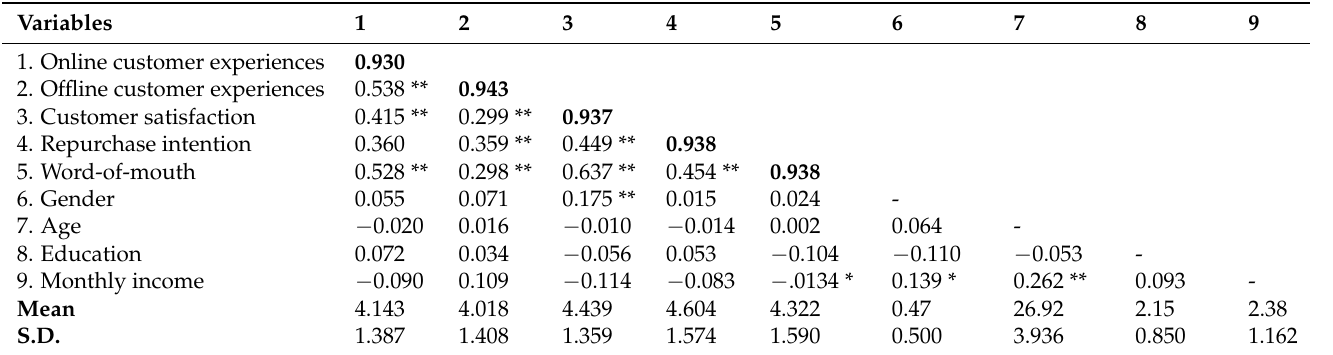
Table 3. Correlation Matrix ( n =